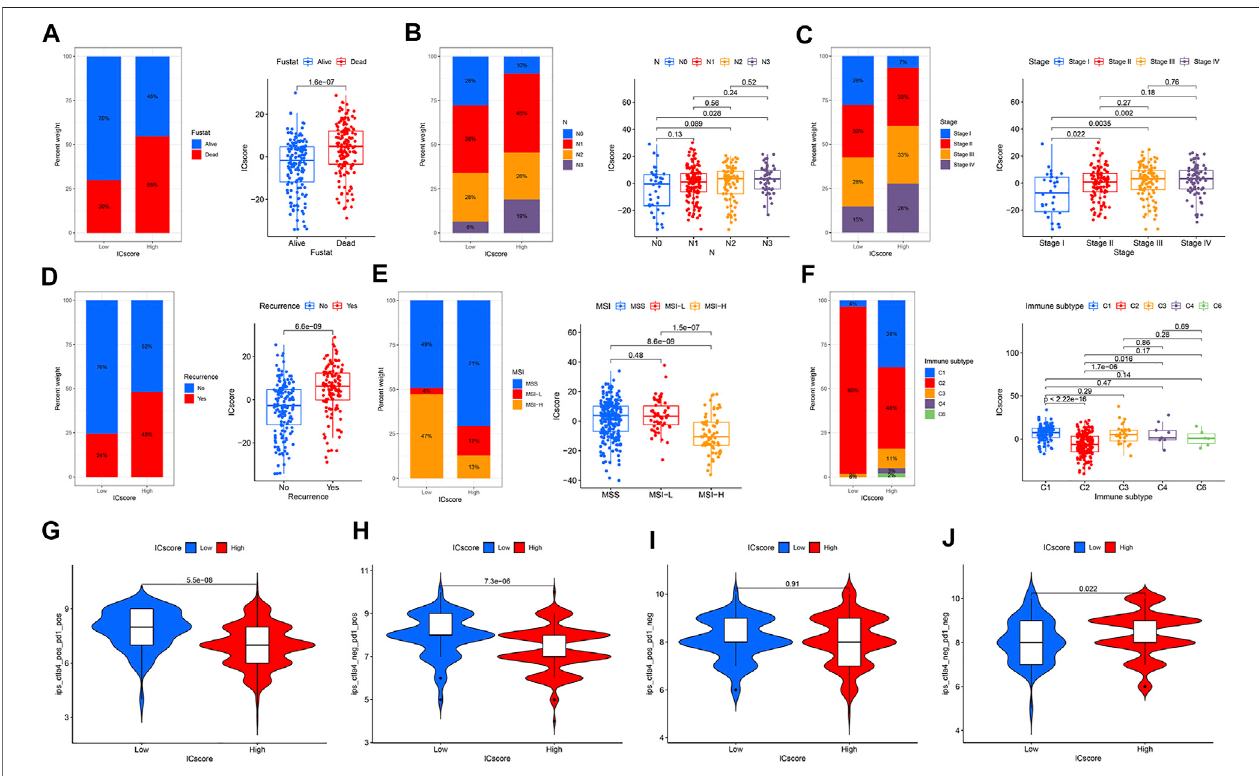
FIGURE6| CorrelationbetweenICscoresignaturesandclinicalcharacteristics. (A – F) Theproportionsanddifferencesofsurvivalstatus (A) ,Nstage (B) ,Stage (C) , recurrence (D) , MSI (E) , and immune subtype (F) in distinct ICscore groups (G – J) IPS of different ICscore groups in various CTLA4/PD-1 status.